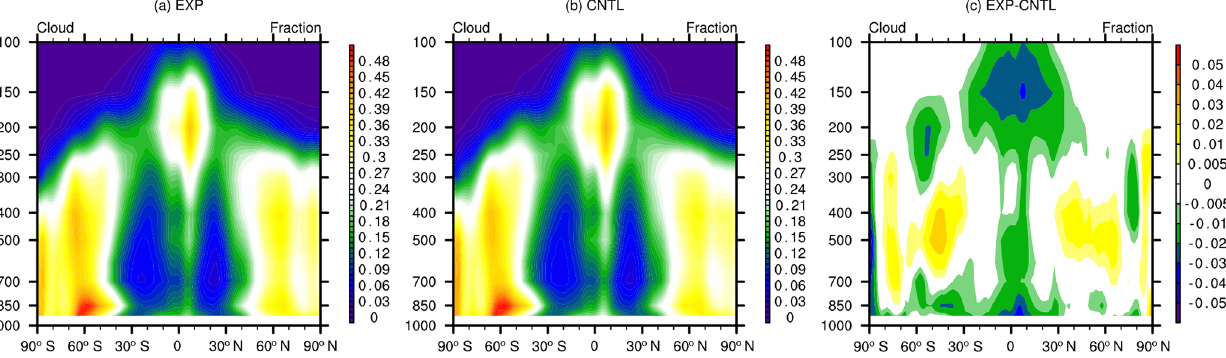
periment forced with prescribed seasonal climatology of SST and sea